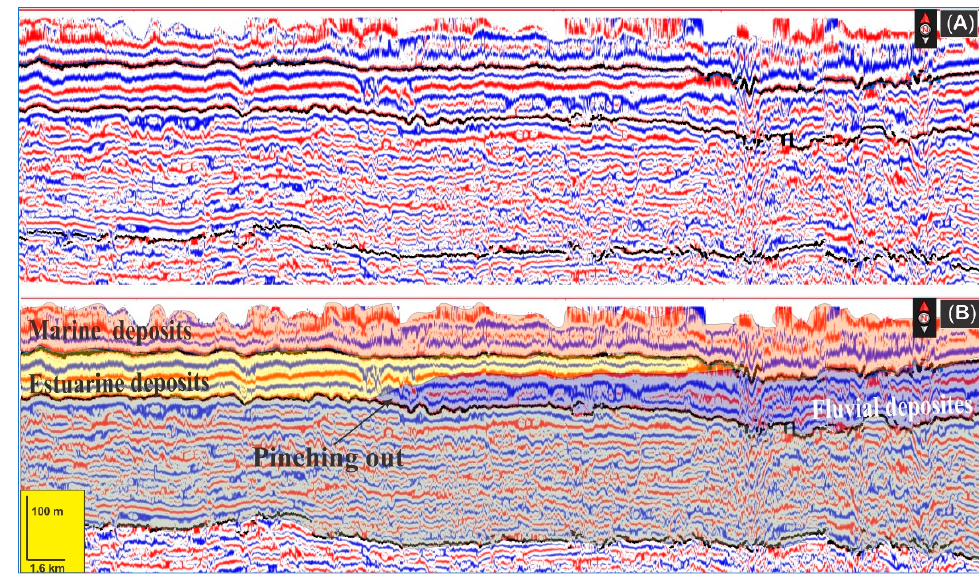
Figure 9. Uninterpreted section in ( A ), and ( B ) the interpreted Cosine of Phase seismic attribute cross-section displaying the fluvial depositional system (Blue color). Estuarine deposits formed onlaps against the fluvial channel walls (Yellow). The estuarine and fluvial deposits are laterally capped by marine deposits (Orange).